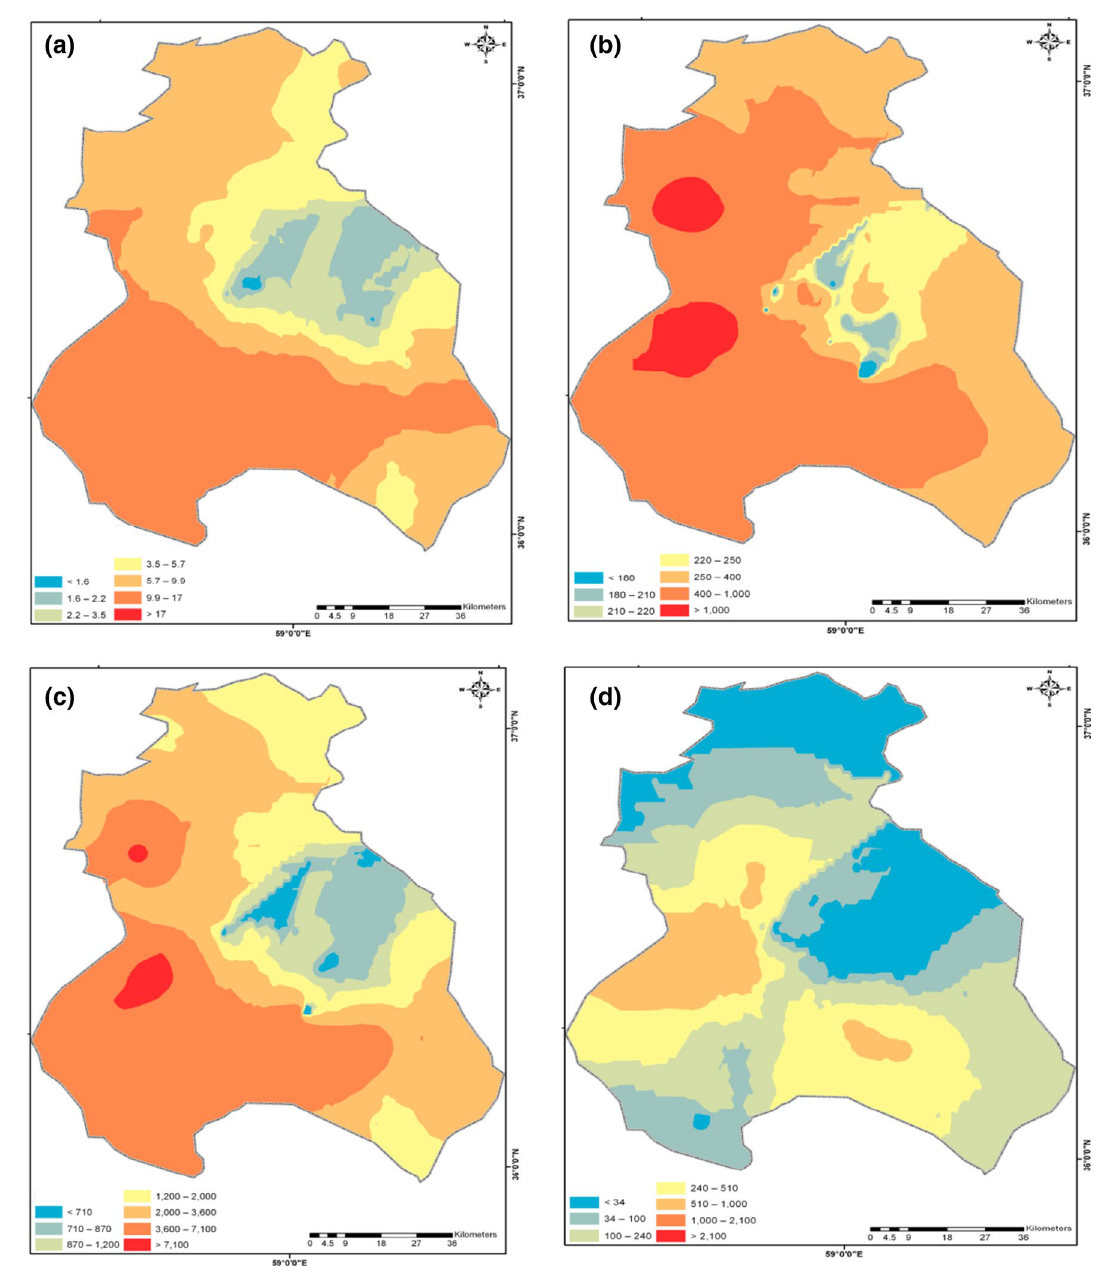
Fig. 5 Spatial distribution of a sodium adsorption ratio (SAR). b Hardness (TH, mg CaCO dissolved solids (TDS,